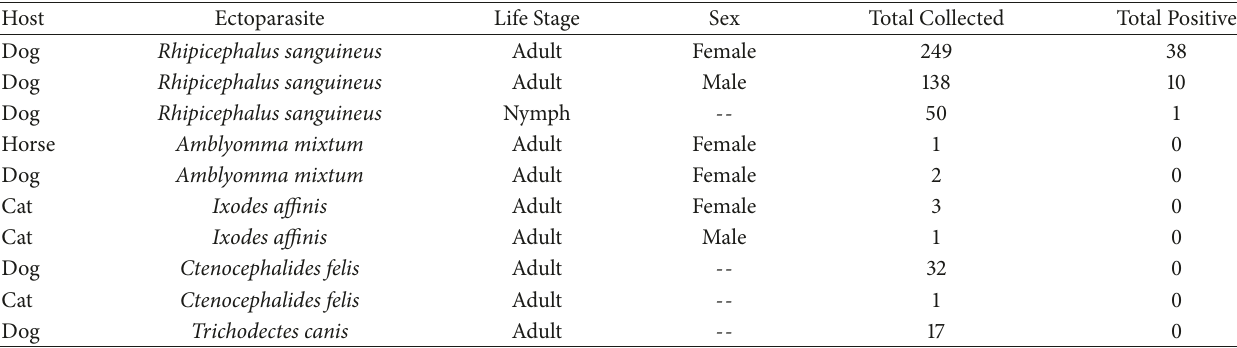
Table 1: Data from collected